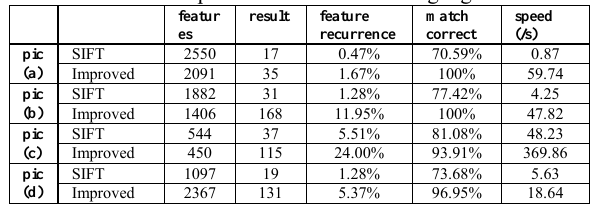
Table 1 comparison with two matching algorithms